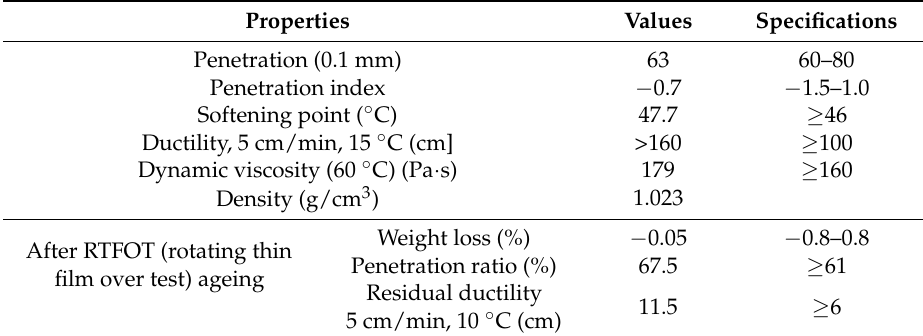
Table 3. Basic properties of the asphalt binder.